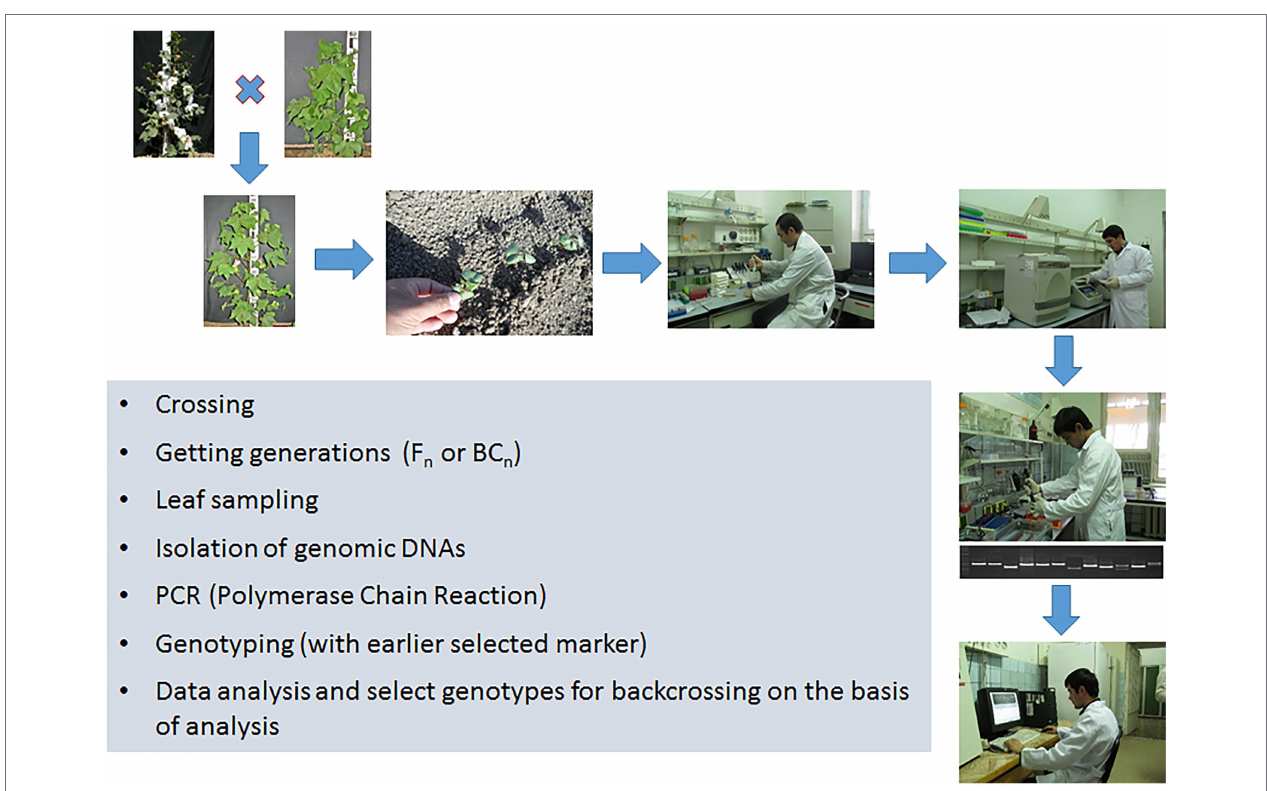
FIGURE 3 | The main procedures of marker-assisted selection